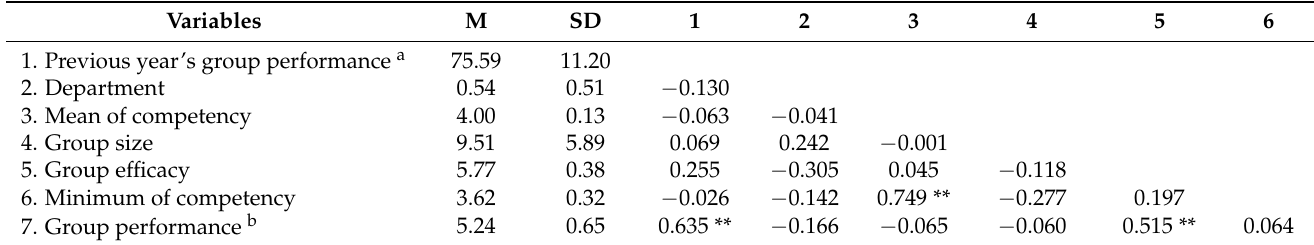
Table 2. Means, Standard Deviations, and Correlations among the Study